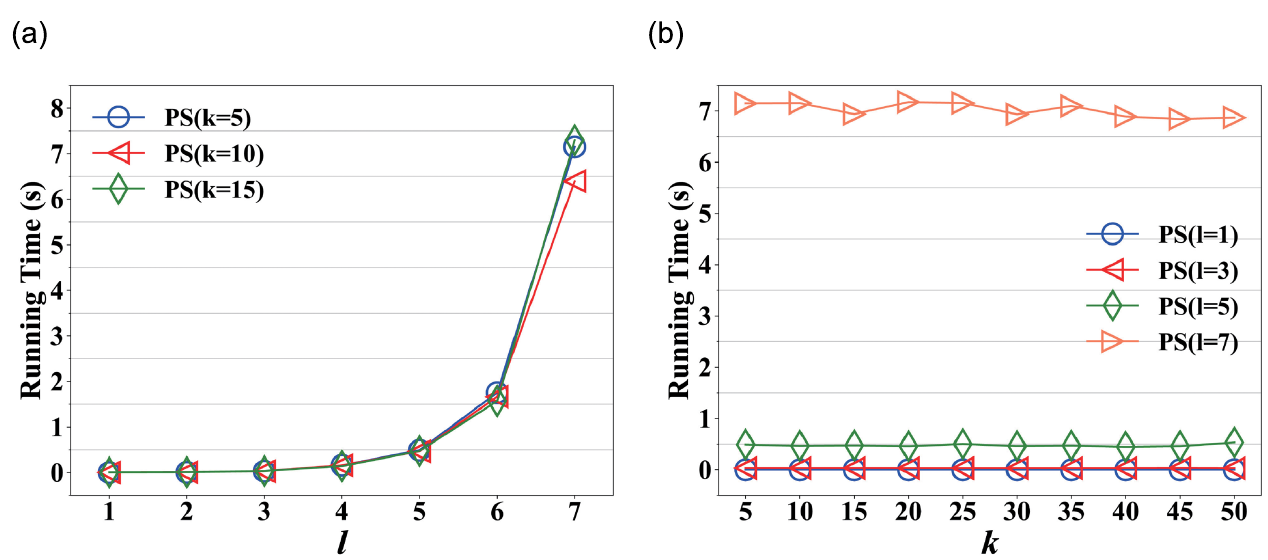
Fig 4. Running time on varying l and k respectively in Nipic. (a) Running time on varying l , (b) Running time on varying k .